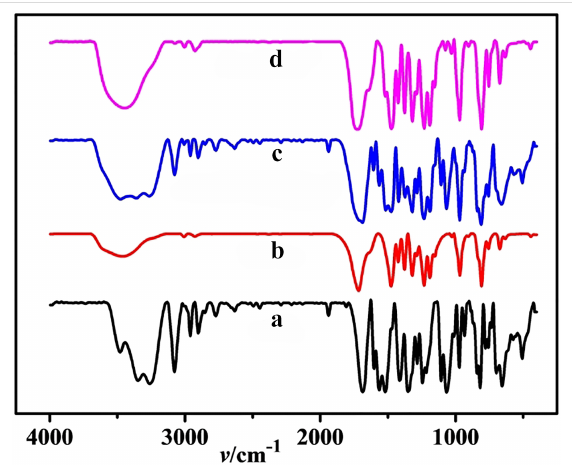
Figure 6: IR spectra recorded for Q[8] (a), CPE (b), a physical mixture of Q[8] and CPE (c), and the CPE@Q[8] inclusion complex